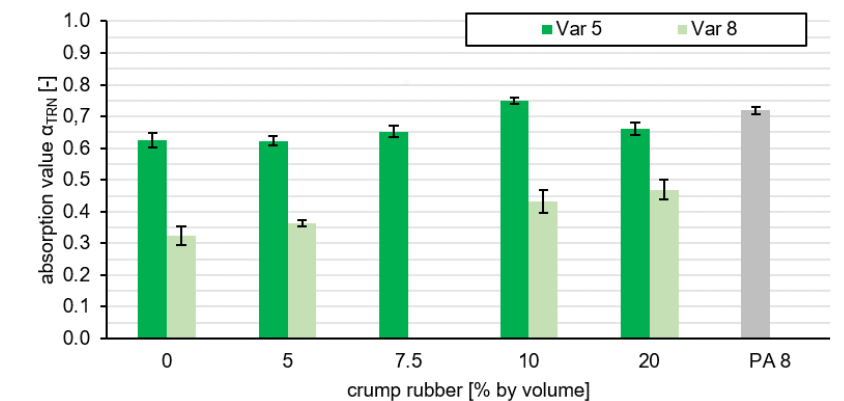
Figure 8. Representation of the absorption value via the proportion of crumb rubber.